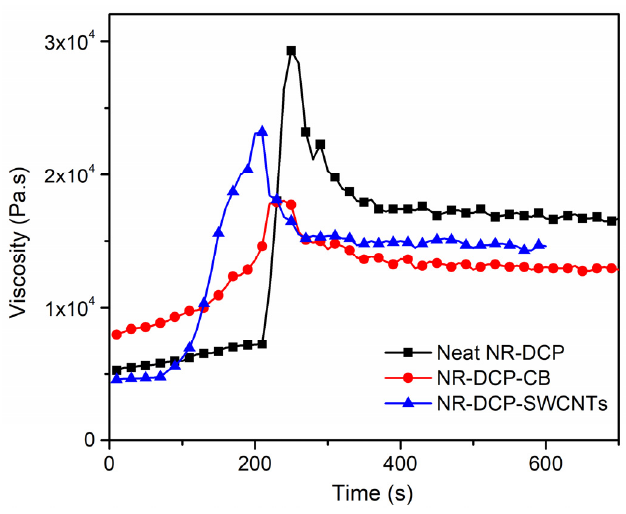
Figure 2. Curing curves of the NR composites using DCP at 160 °C.